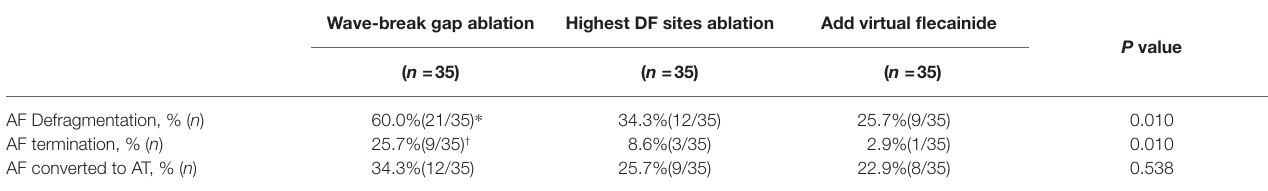
TABLE 3 | Defragmentation rates after interventions for 35 AF PVI-gap